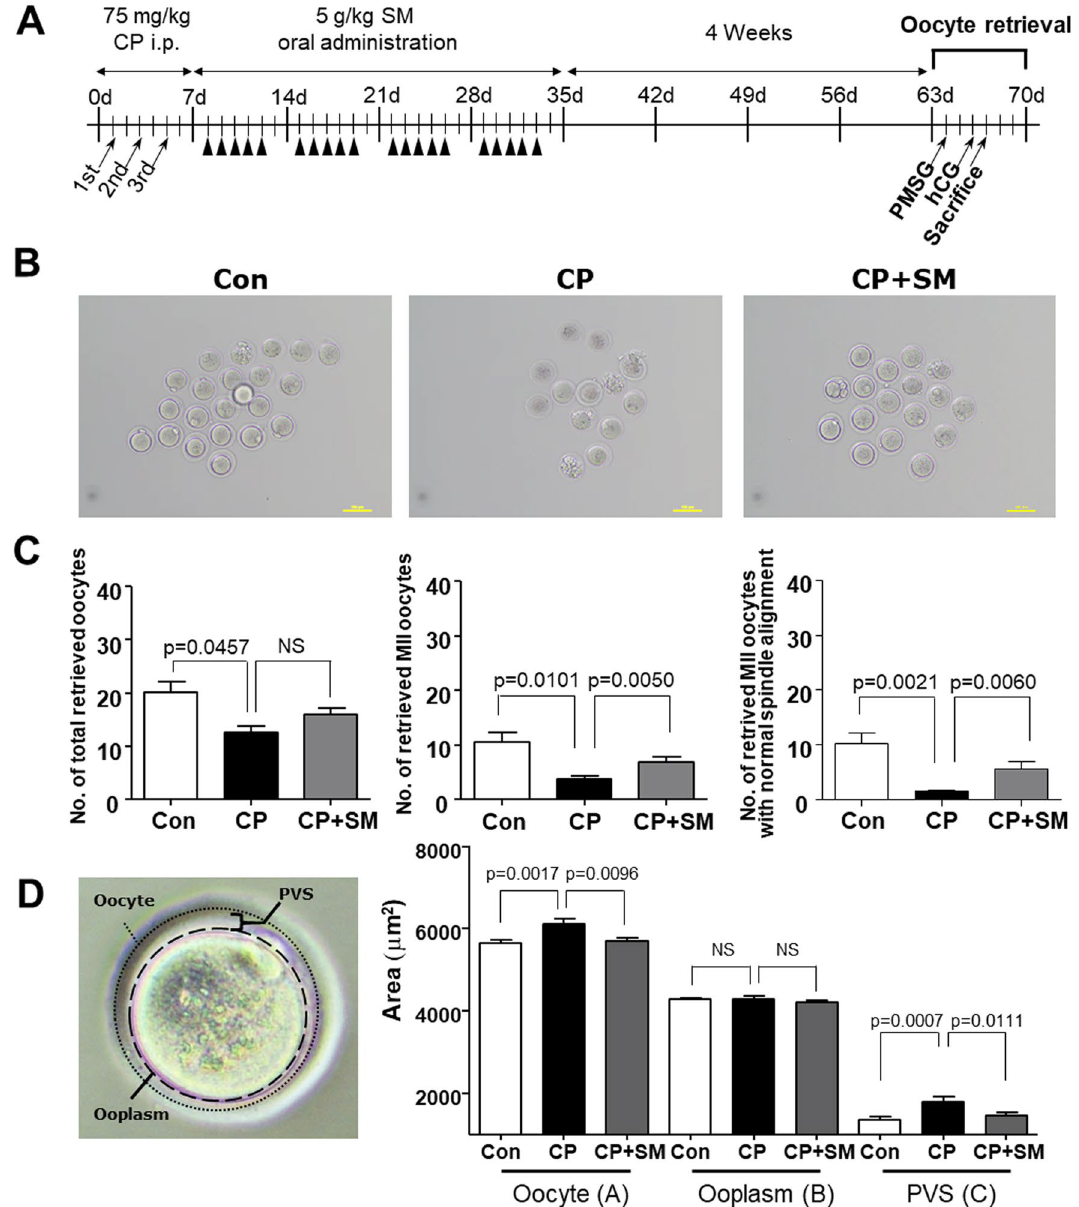
Figure 3. Quality and quantity of mouse oocytes retrieved at 4 weeks after Samul-tang (SM) administration. ( A ) Mice were injected with saline (n = 5, Con group) or cyclophosphamide (CP) on days 1, 3, and 5 in the first week; mice injected with CP were then orally administered distilled water (n = 5, CP group) or 5 g/kg SM (n = 5, CP + SM group) five times a week for 4 weeks. Four weeks after SM administration, the mice were superovulated via intraperitoneal injections of 5 IU of pregnant mare serum gonadotropin (PMSG) and 5 IU of human chorionic gonadotropin (hCG) at 48 h after PMSG injection. ( B ) Oocytes retrieved at 18 h after hCG injection from the Con, CP, and CP + SM mice. ( C ) Numbers of oocytes, MII oocytes, and MII oocytes with normal chromosomal and spindle alignment, retrieved from the three mouse groups. ( D ) Areas of oocytes, the ooplasm, and perivitelline space (PVS) in the three mouse groups. Statistical analysis was performed using the Student’s t -test. Scale bars indicate 100 µm. Arrows and arrowheads indicate the days of CP injection and SM administration, respectively. NS not